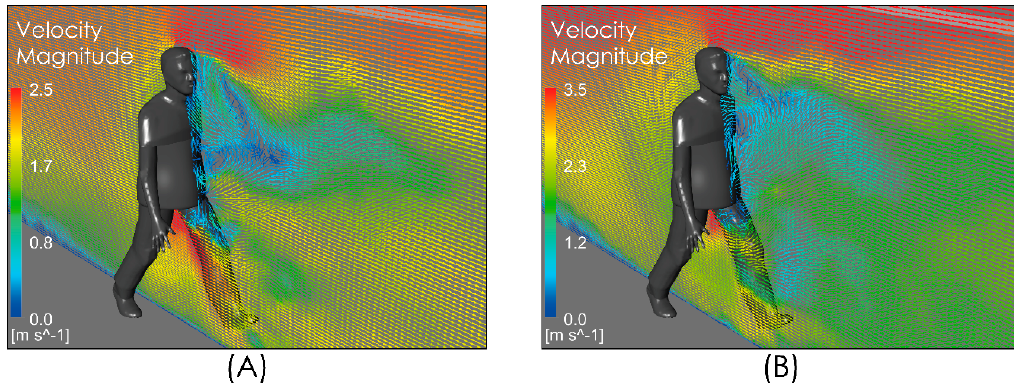
Figure 5. Vector velocity field near person. Moderate intensity airflow of 2 m/s ( A ) and intense airflow of 4 m/s ( B ).